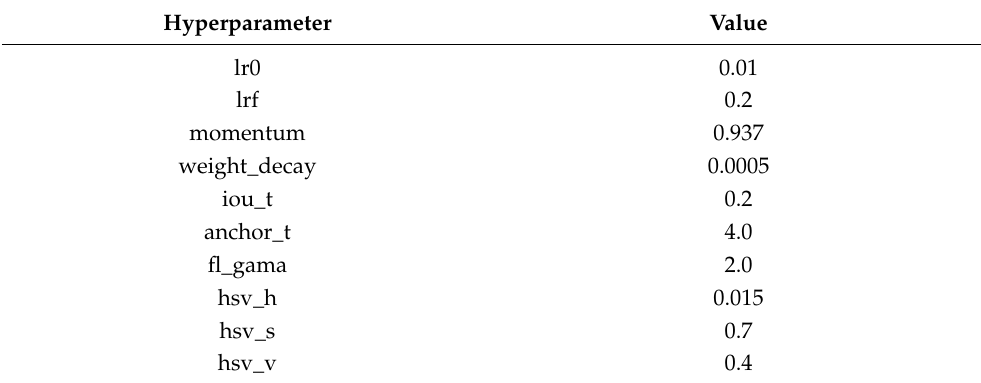
Table 2. The hyperparameter settings for the network